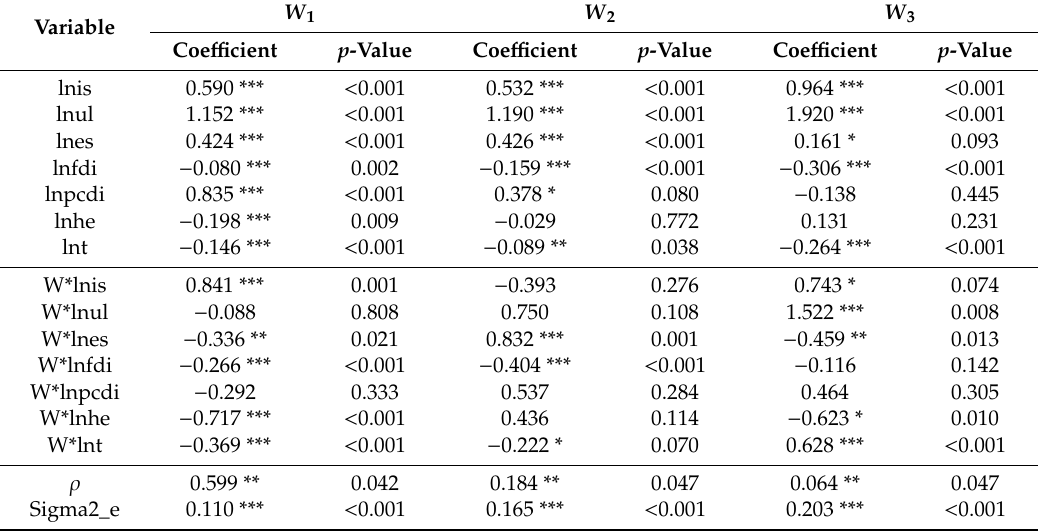
Table 5. Estimation results of the impact of influencing factors on